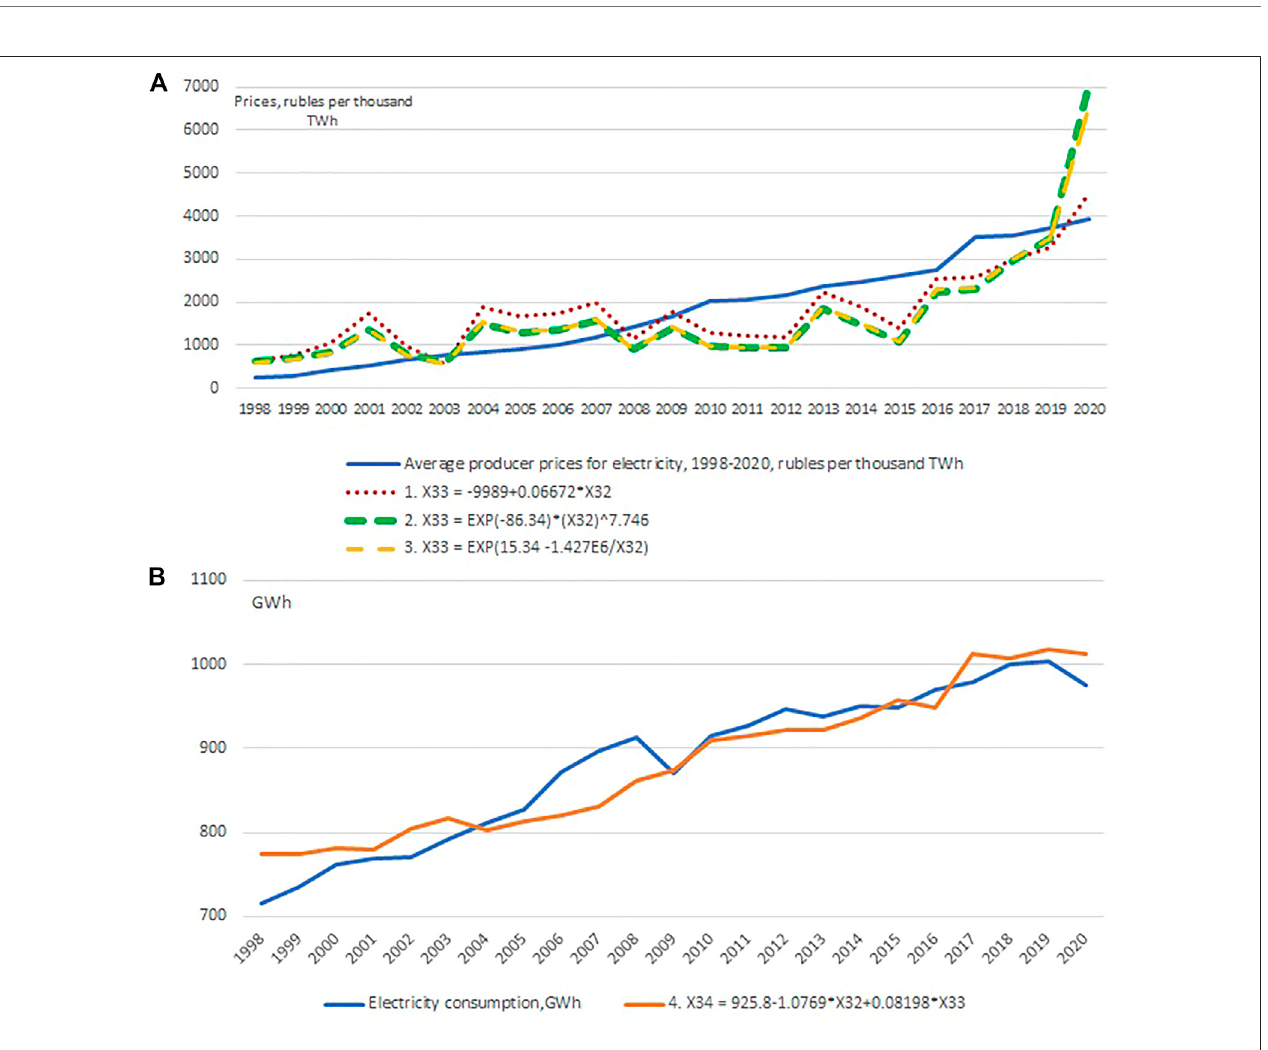
FIGURE 2 | Regression modeling results and real data for electricity price (A) and electricity consumption (B) .